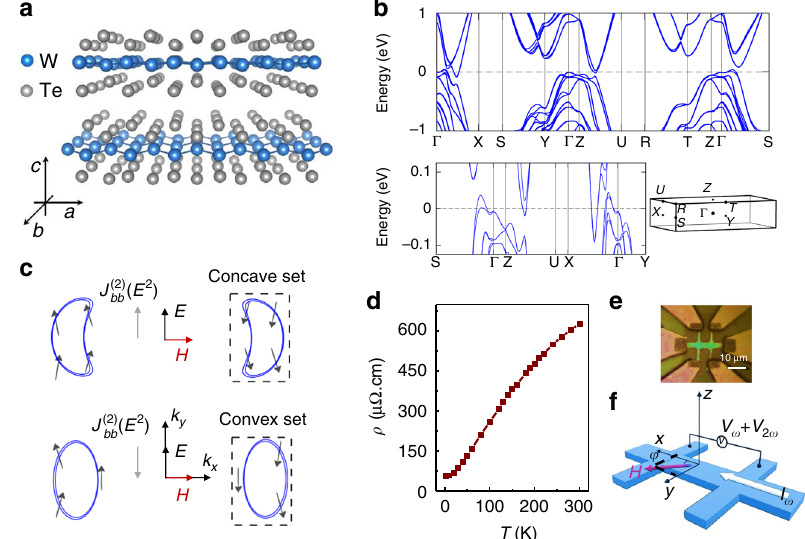
Fig. 1 Crystal and band structures and nonlinear magnetotransport in WTe 2 . a Crystal structure of the layered WTe 2 and its crystalline directions. b The calculated band structure of bulk WTe 2 , where the high symmetry k points are indicated in the 3D Brillouin zone sketched underneath. A magni fi ed plot of the band dispersion is also shown to emphasize details of the electron and hole pockets. c Schematic Fermi surfaces at two representative Fermi energies illustrating the distinct convexity (see Fig. 4b for the full realistic Fermi surfaces and contours of bulk WTe 2 at T = 0 K). Under a magnetic fi eld H perpendicular to the applied electric fi eld E (along b axis), a nonlinear charge current density J ð 2 Þ bb at the second-order in E is generated along the b direction. J ð 2 Þ bb has opposite sign at the two Fermi energies. d Temperature-dependent resistivity ρ with a thickness of 34 nm WTe 2 . e A typical optical image of Hall bar devices. f Schematic of harmonic magnetoresistance (MR) measurements while rotating H in the xy plane at an angle φ with the